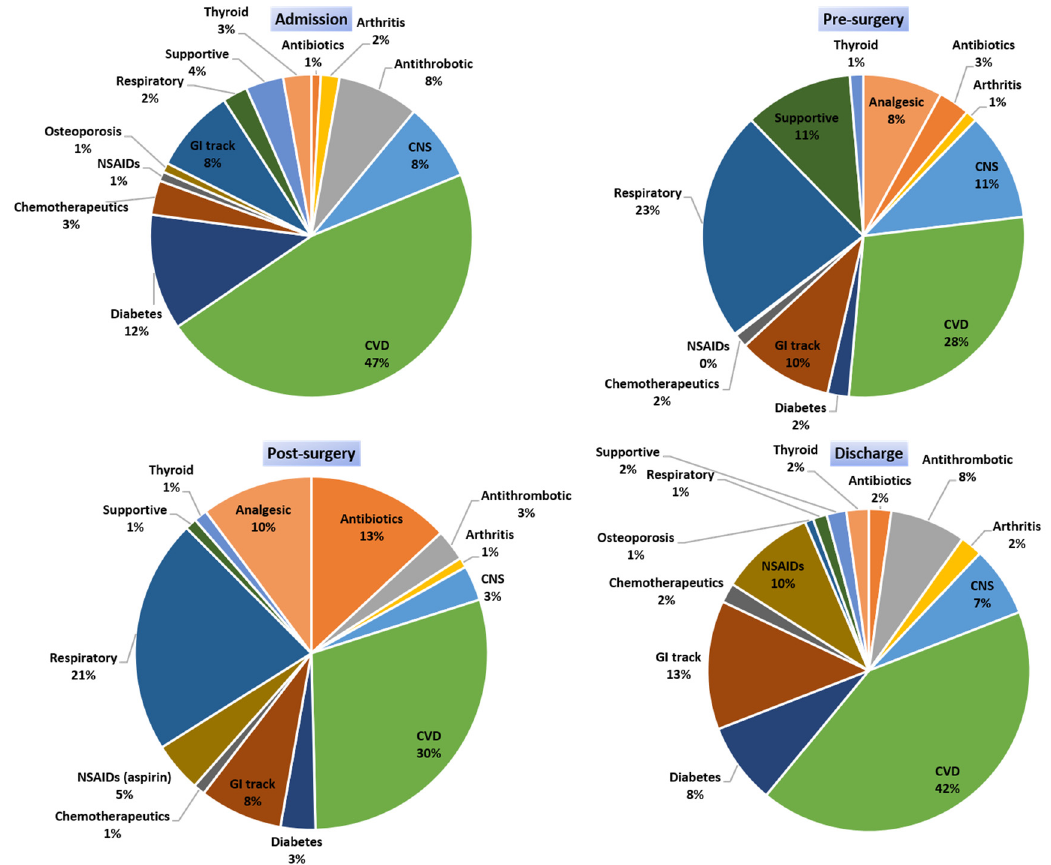
Figure 2. Medication categories that were administered at the different time points of the study. (CVD: cardiovascular disease medications; CNS: central nervous system; GI track: H2 blockers and PPIs: proton-pump inhibitors; antacids NSAIDs: nonsteroidal anti-inflammatory drugs; supportive: supplementary products such as electrolytes, lactulose, ferrous, etc.).